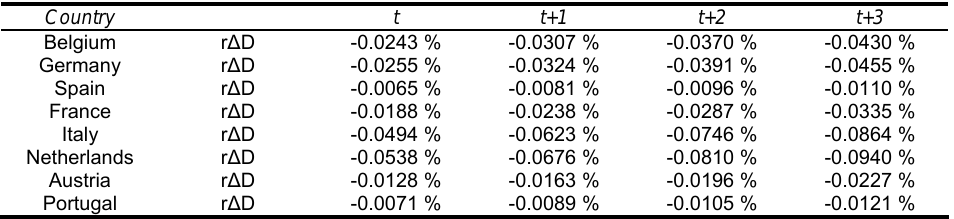
Table 15. The additional interest payments when no corrections are made, using the additive constant approach